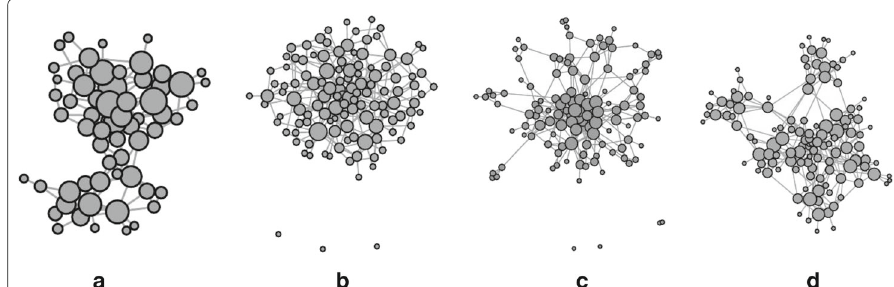
are not among the fastest generators, but fast enough to produce millions of edges in